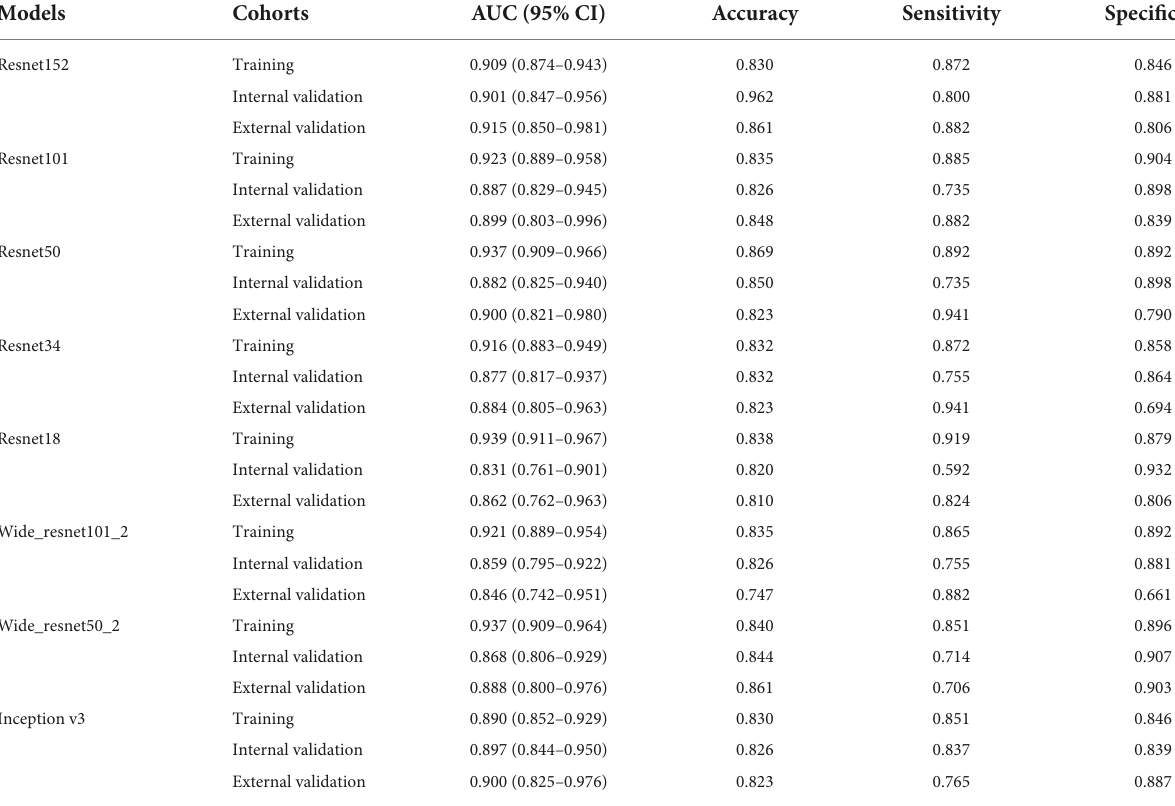
TABLE 2 Difference of various deep transfer learning